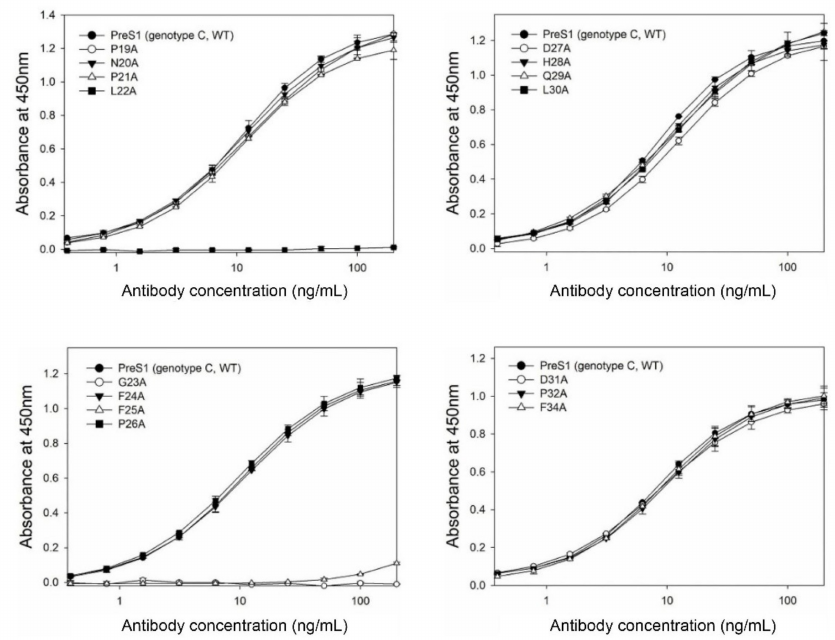
Figure 2. Analysis of the antibody-binding activities of purified GST–preS1 (aa 1–56)–strep carrying an alanine substitution by indirect and quantitative ELISAs (Figure S1). The wild-type (WT; genotype C) was included as a positive control. Values were obtained from duplicate wells and are expressed as the mean ± SD.